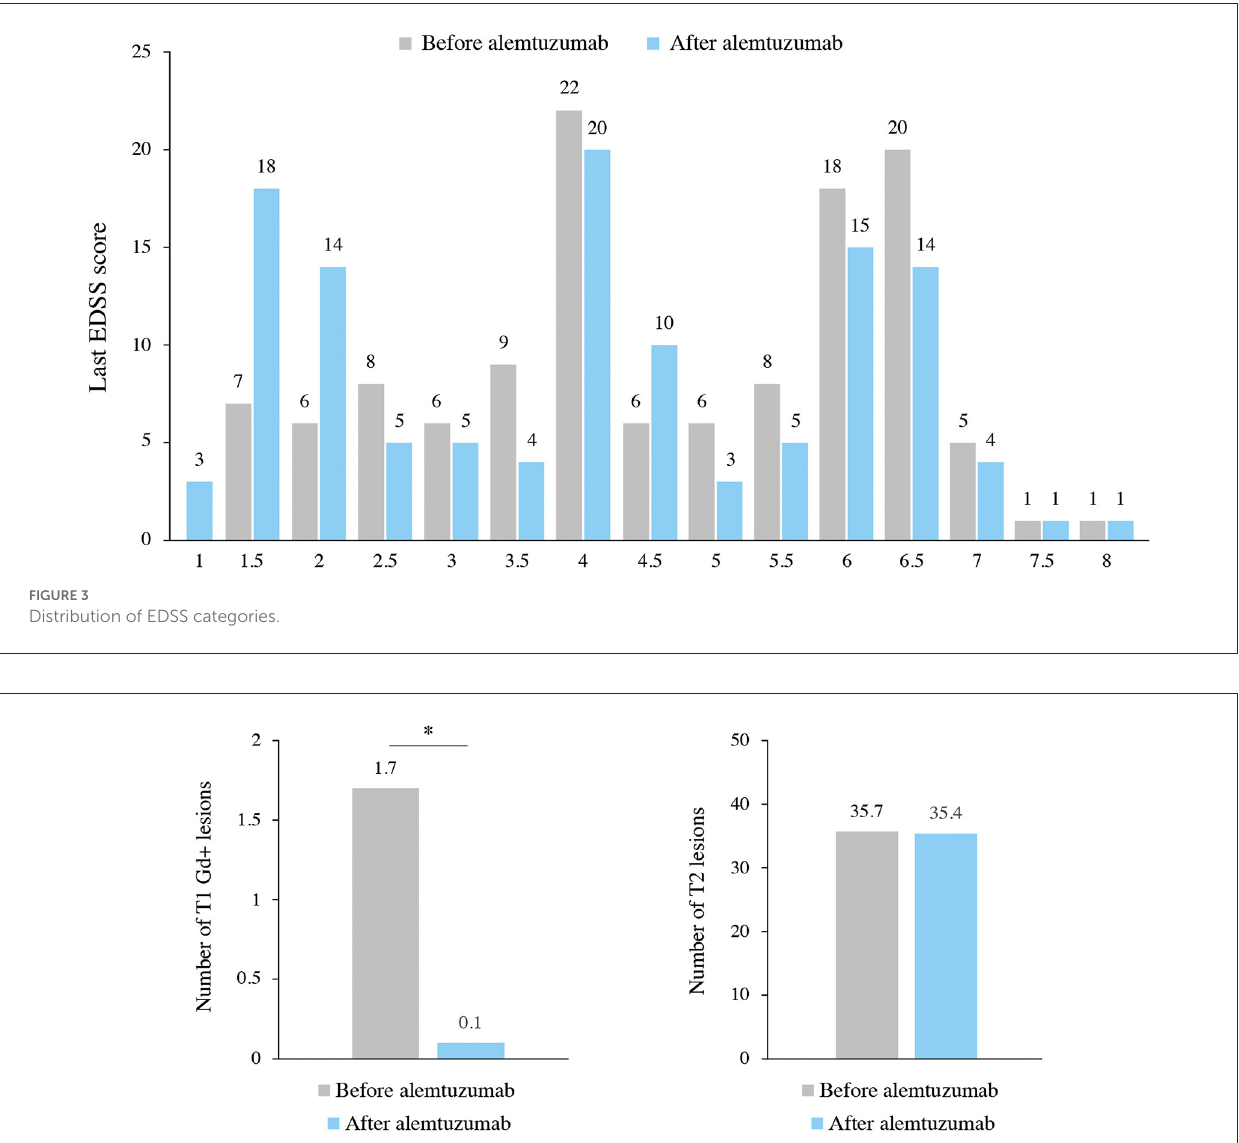
FIGURE4 MRI lesion activity before and after alemtuzumab treatment. * p <